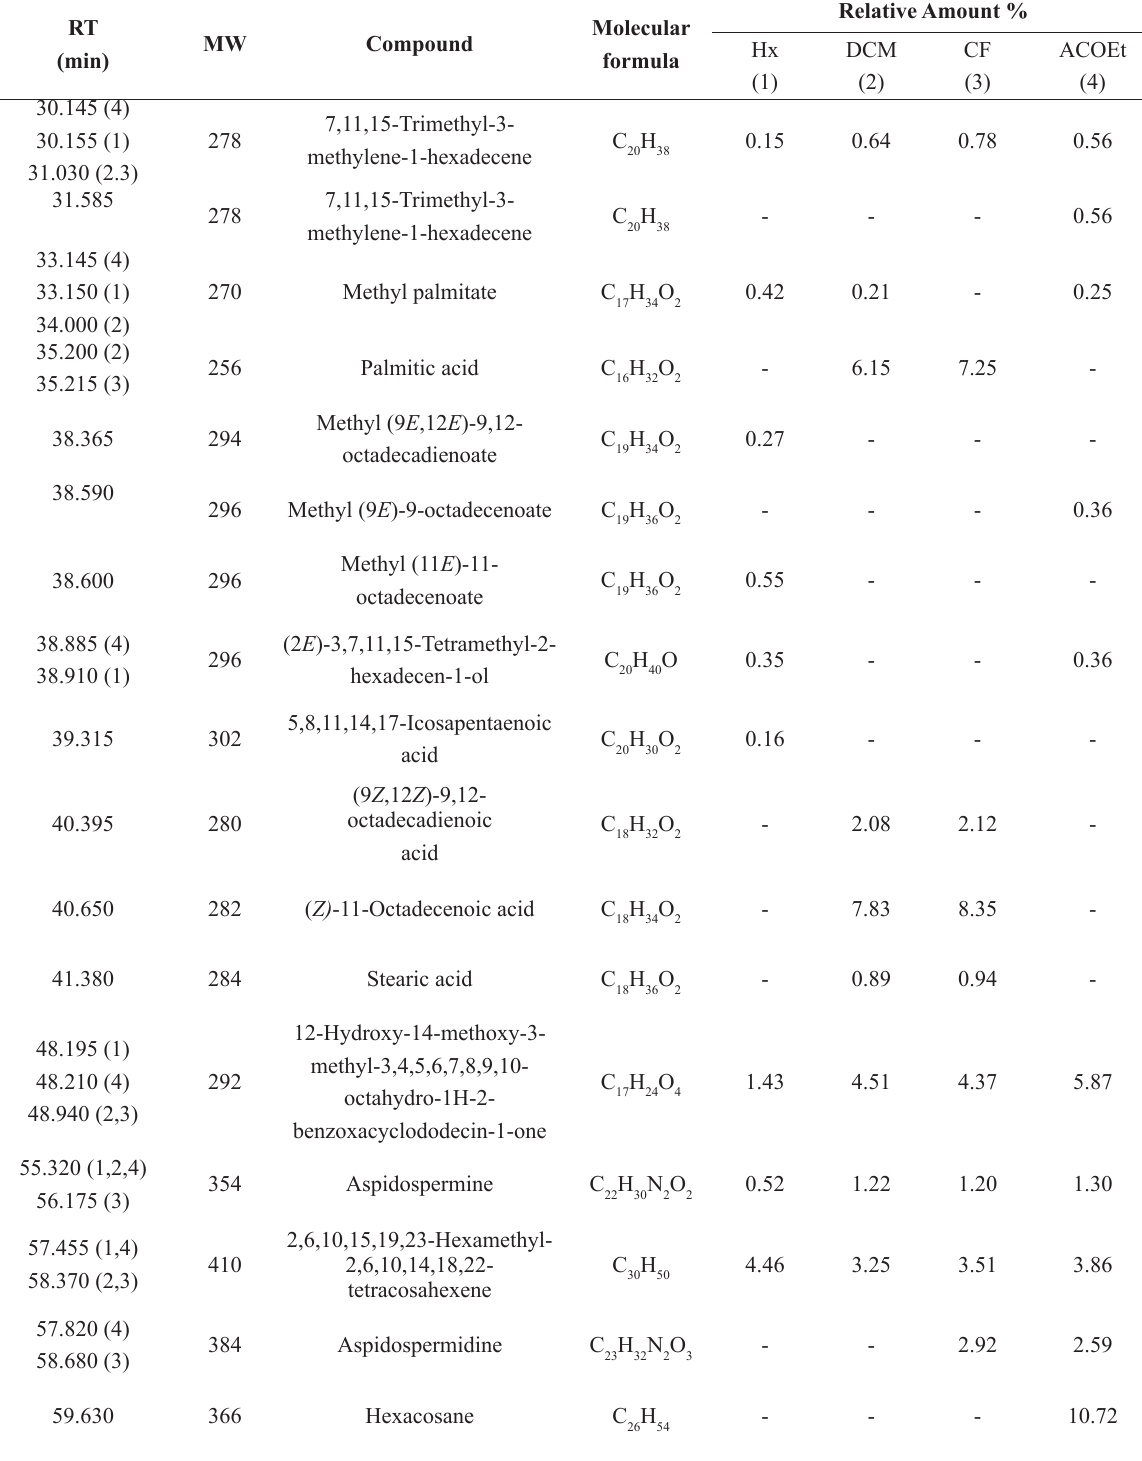
Constituents identified in extracts of leaves of P. mucronatum by GC/MS with the highest similarity indices or equal to